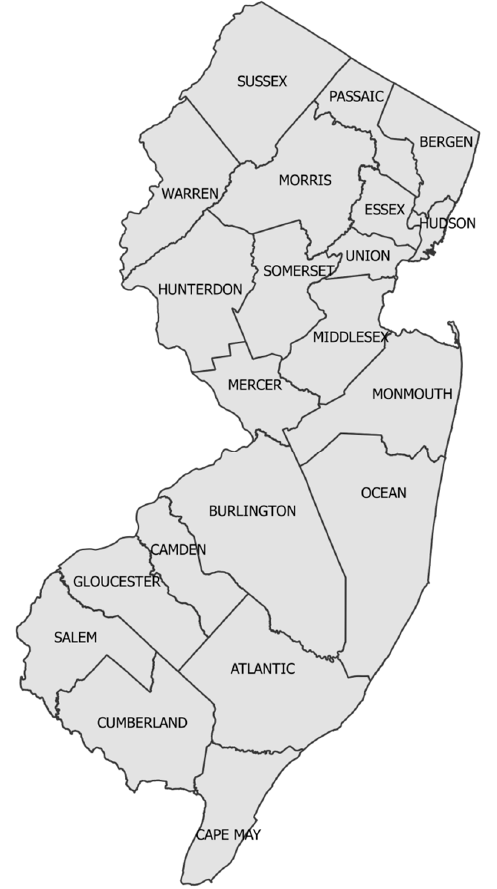
Figure 1. Map of New Jersey with 21 counties, each of which has a locally funded mosquito control program.